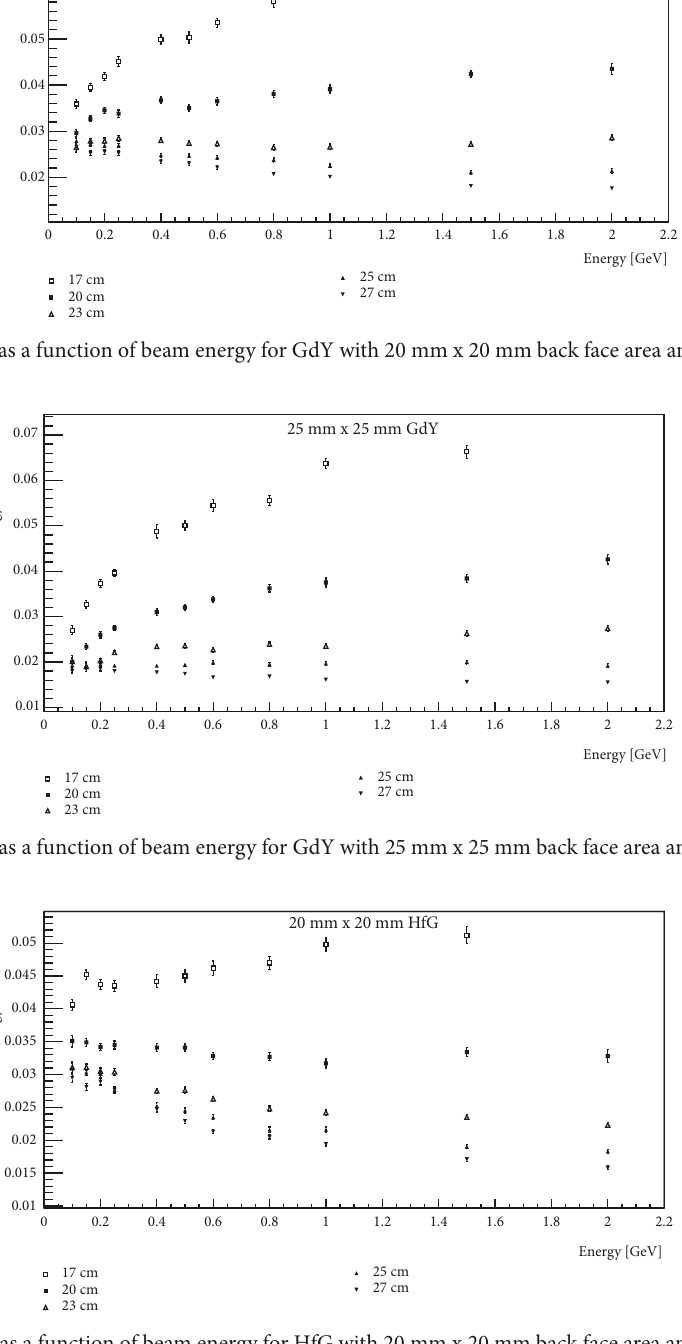
a homogenous calorimeter in particle physics